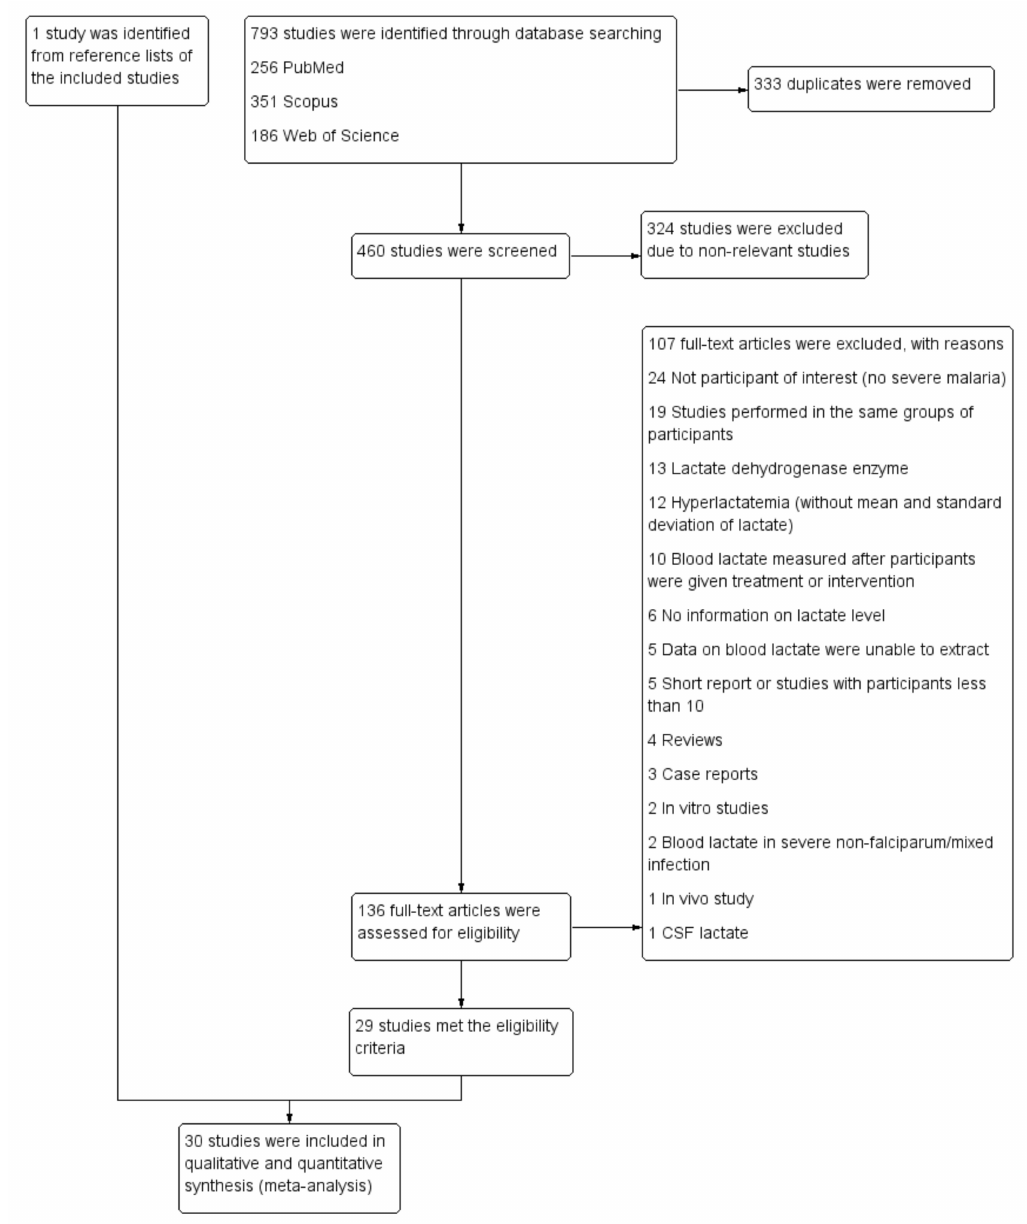
Figure 1. Study flow diagram. Abbreviation: CSF, cerebrospinal